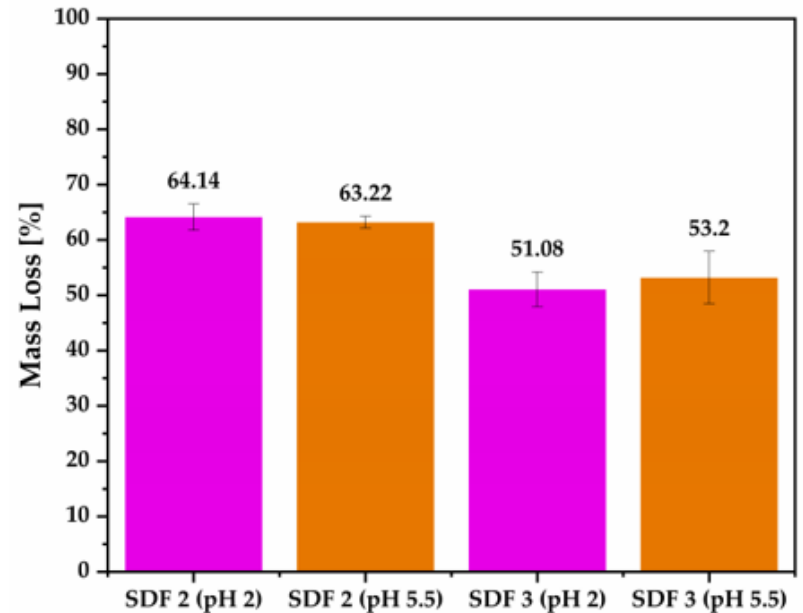
Figure 11. Percentage of mass loss from moulded tablets based on PEO and PCL blends after 21 days of exposition to dissolution medium at pH 2 and pH 5.5.